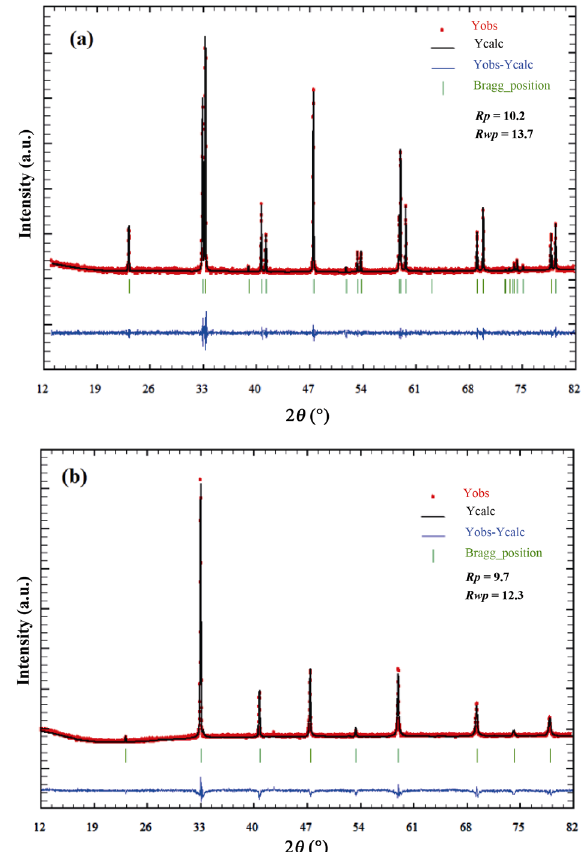
Fig. 2 Rietveld refinement results of XRD patterns for (a) La 0.9 Ba 0.1 CoO 3 ( x = 0.1) and (b) La 0.25 Ba 0.75 CoO 3 ( x = 0.75). The experimental data are shown as dots; the global fitting profile and the difference curve are shown as solid lines; the calculated reflection positions are indicated by stick